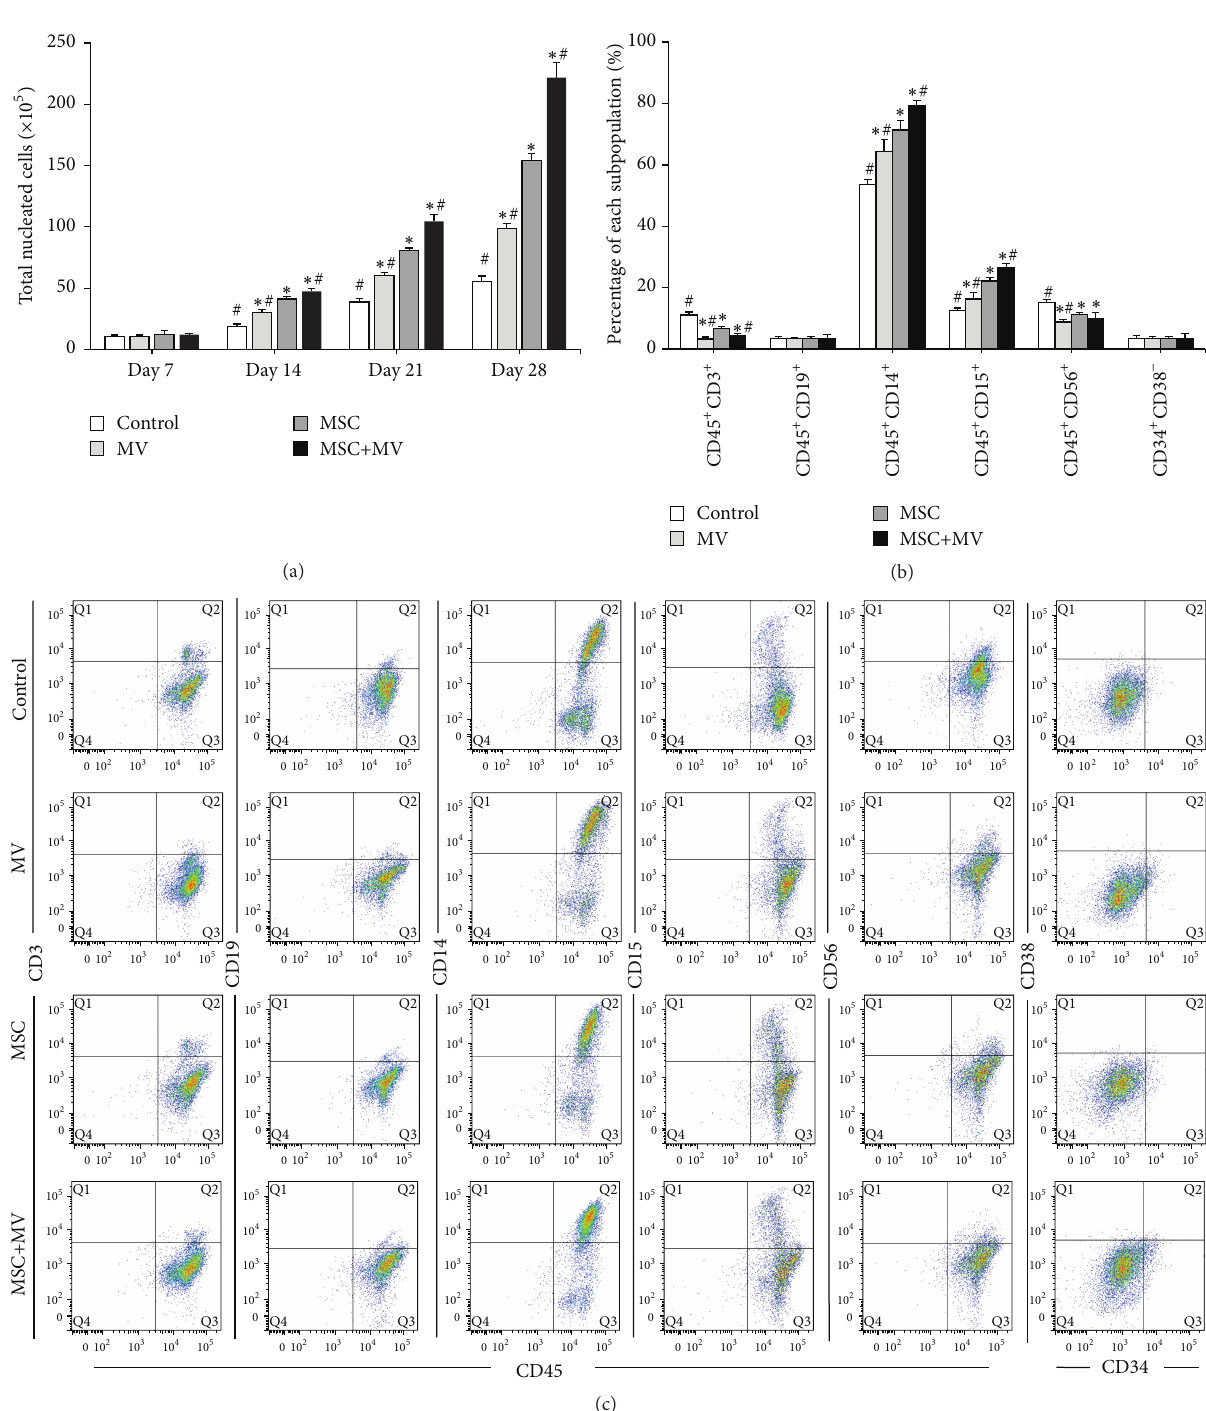
Figure 3: Ex vivo expansion of CB-MNCs. CB-MNCs were maintained under four different culture conditions: control, MV, MSC, and MSC+MV. (a) Growth profile of TNCs ( 𝑛 = 3 ), ∗ 𝑃 < 0.05 compared with the control group, # 𝑃 < 0.05 compared with the MSC group. (b) Immunophenotype of subpopulations of expanded CB-MNCs analyzed by flow cytometry on day 7 ( 𝑛 = 3 ), ∗ 𝑃 < 0.05 compared with the control group, # 𝑃 < 0.05 compared with the MSC group. (c) Representative flow cytometric dot blot diagrams of each